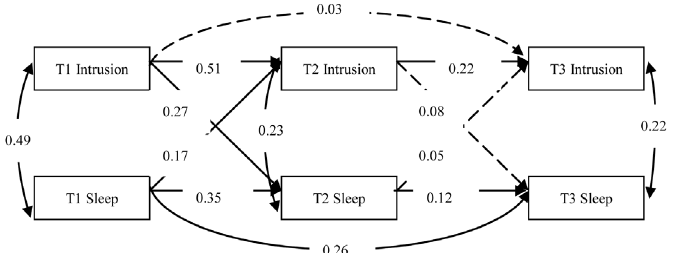
Figure 1. The model for the evaluation of the relationship between intrusive symptoms and sleep problems after controlling the other two symptom clusters of PTSD (Model 1). Dashed lines indicate insignificant paths. Intrusive symptoms=Intrusion, Sleep